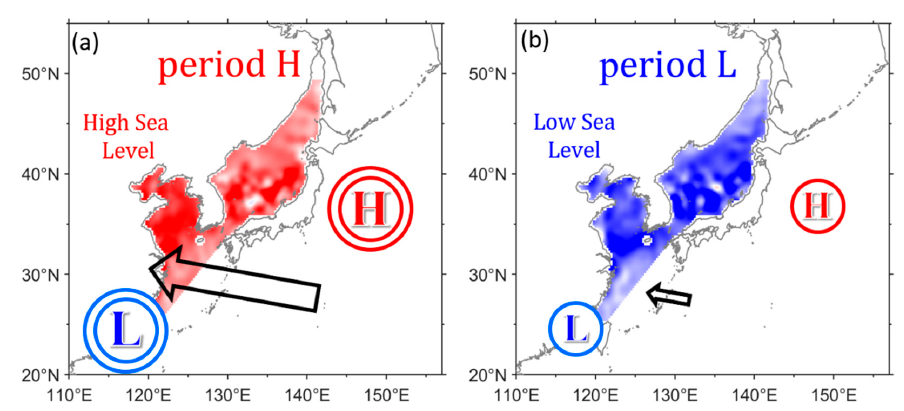
Figure 13. Schematic diagrams accounting for the ANSA. ( a ) Strong west-northwestward wind stress (long black arrow) is a result of large atmospheric pressure gradients (double red and blue circles for H and L, respectively) in the northwest Pacific Ocean. Strong wind stress enhances seawater volume transport from the Pacific into the NEAMS by Ekman transport, which results in high sea-levels in the NEAMS (red) during the period H. ( b ) Weak wind stress (short black arrow) is a result of small atmospheric pressure gradients. Weak wind stress decreases seawater volume transport, which results in low sea-level in the NEAMS (blue) during the period L. Coastlines are drawn in